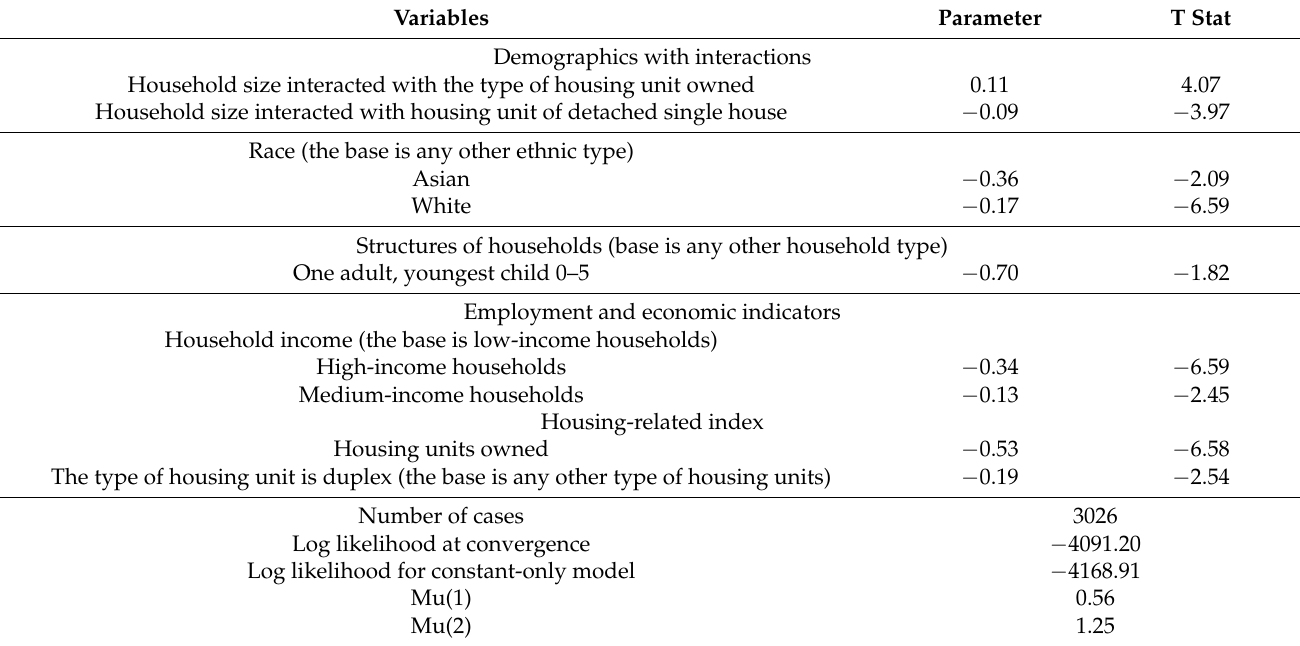
Table 9. Ordered response model of residential choice of 0.5-mile land-use